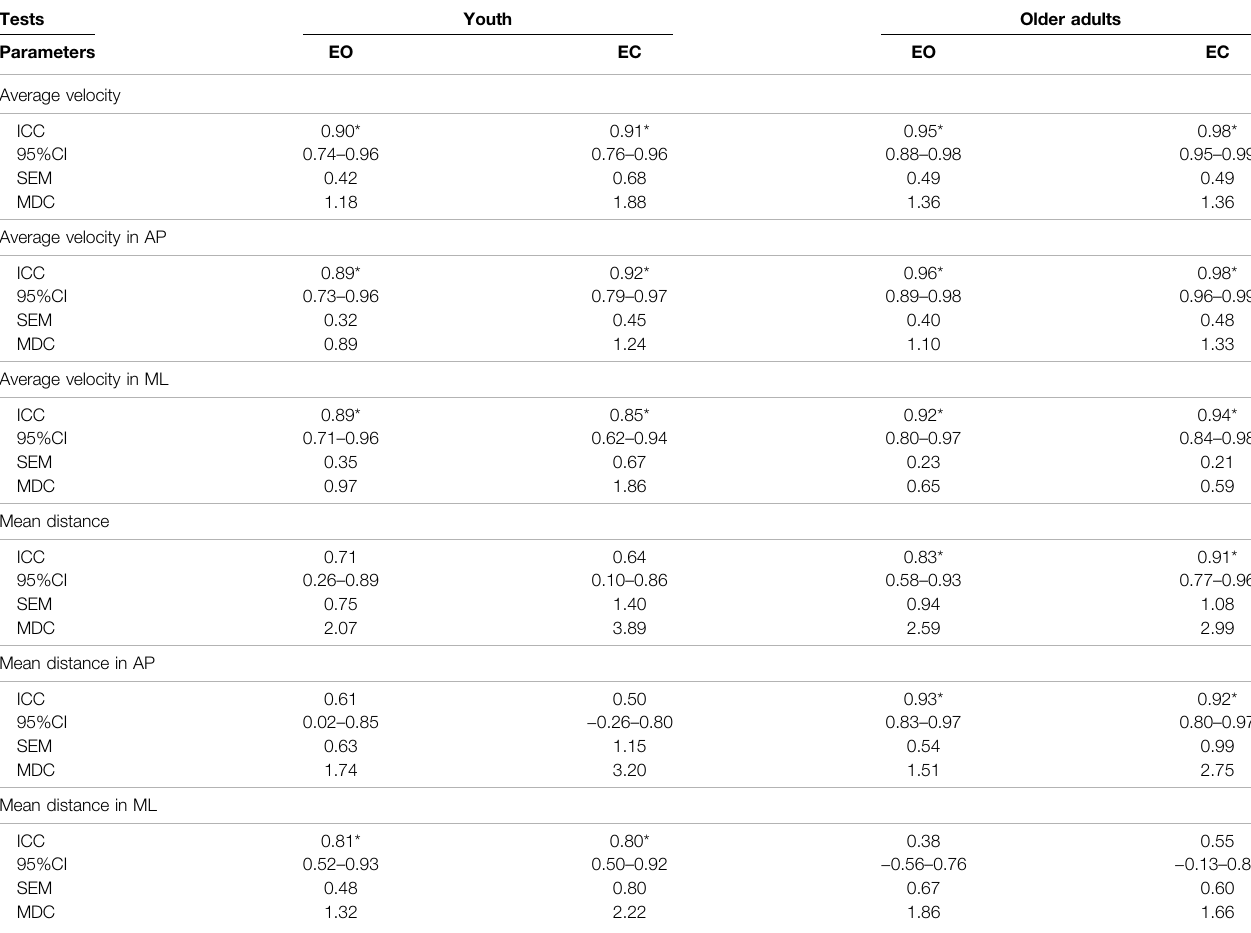
TABLE 3 | Between-days reliability for different COP variables for younger and older